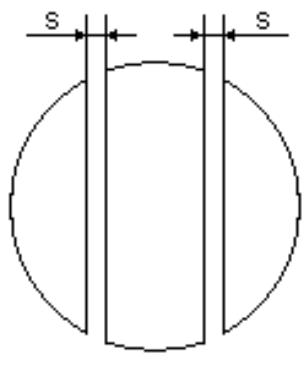
Figure 3. Cut Figure 3. Cut thickness.